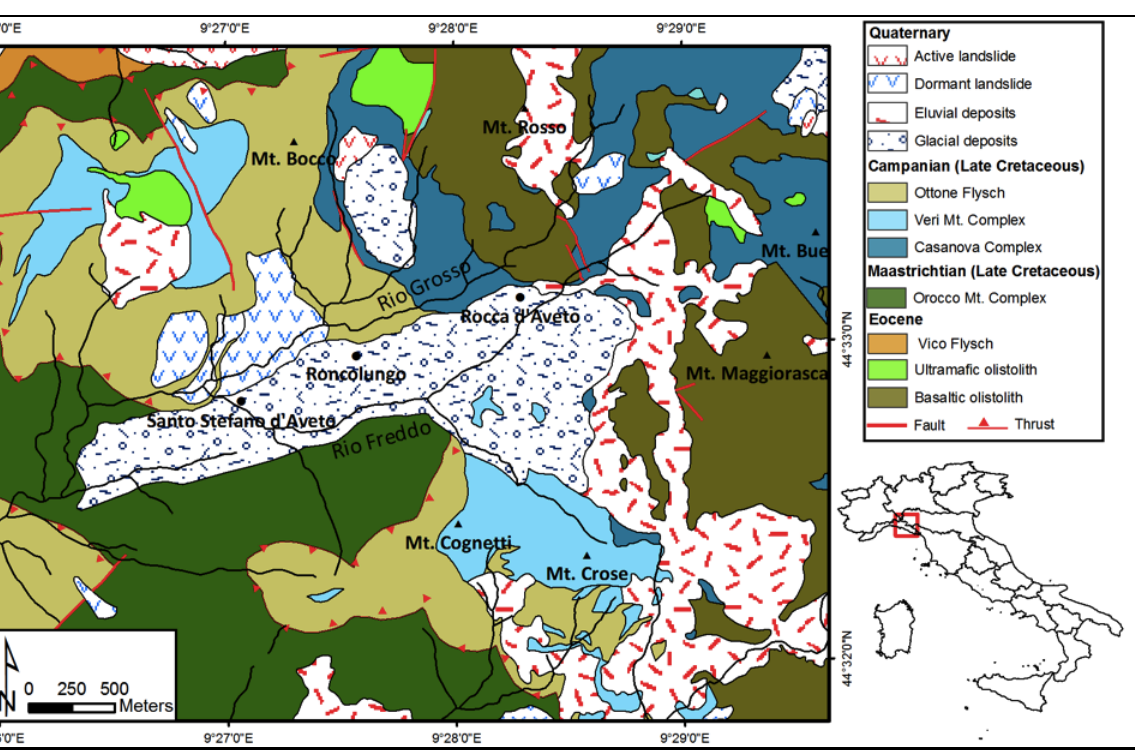
Figure 1. Geologic and structural sketch of the study area (Modified from Carta